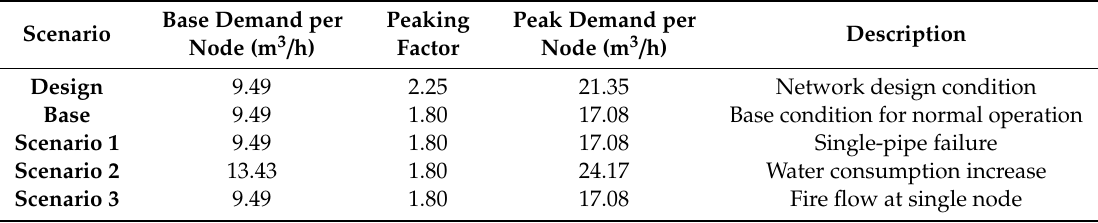
Table 3. Application scenarios